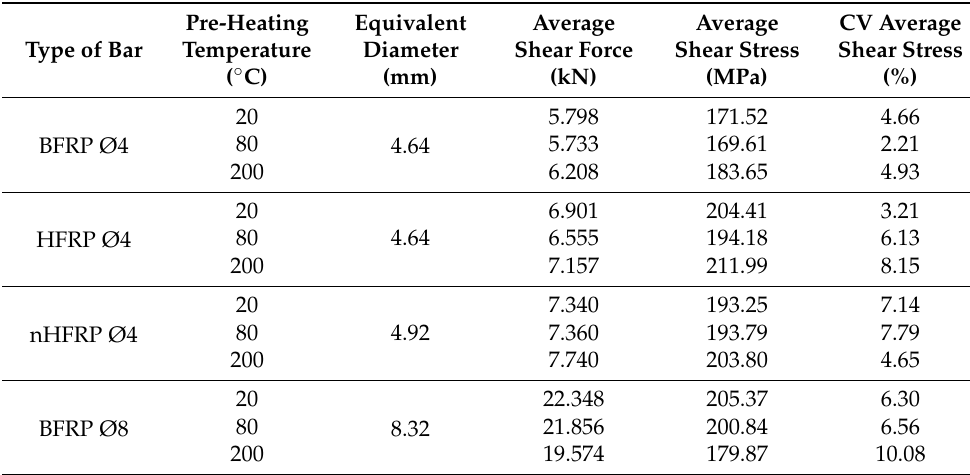
Table 2. Shear test results for Ø4, Ø8, and Ø10. Tested bars: BFRP (basalt fiber-reinforced